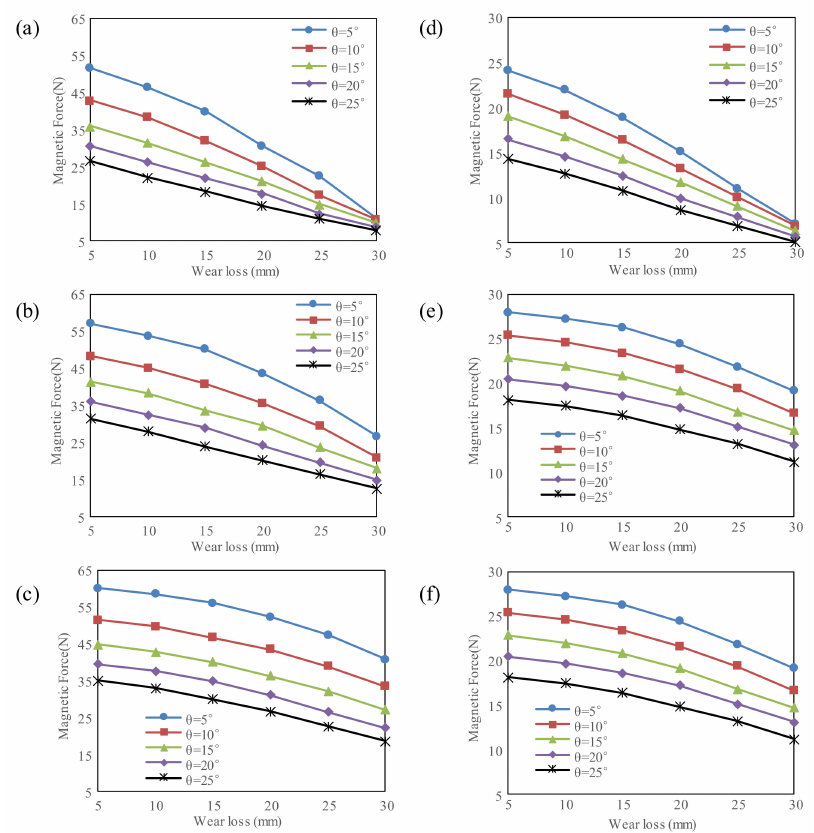
Figure 5. Effect of the location and orientation of the permanent magnet on the magnetic force: ( a ) d m = 0 mm, d s = 10 mm; ( b ) d m = 7.5 mm, d s = 10 mm; ( c ) d m = 15 mm, d s = 10 mm; ( d ) d m = 0 mm, d s = 15 mm; ( e ) d m = 7.5 mm, d s = 15 mm; ( f ) d m = 15 mm, d s = 15